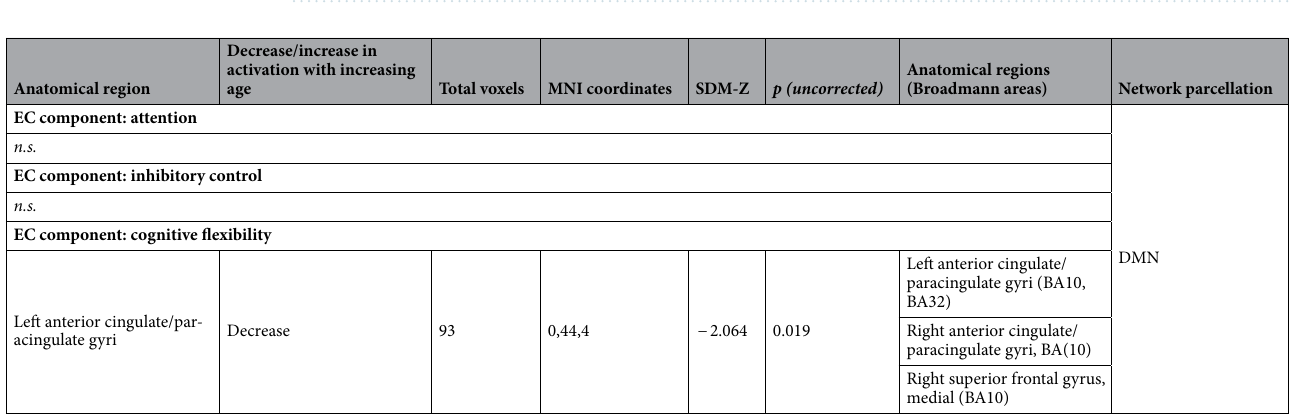
Figure 4. Differences in brain activation between ASD and HC during cognitive flexibility. Cluster with blue colour indicates hypoactivation when compared with HC ( p < 0.005, uncorrected; L left, R right, ACC anterior cingulate cortex).